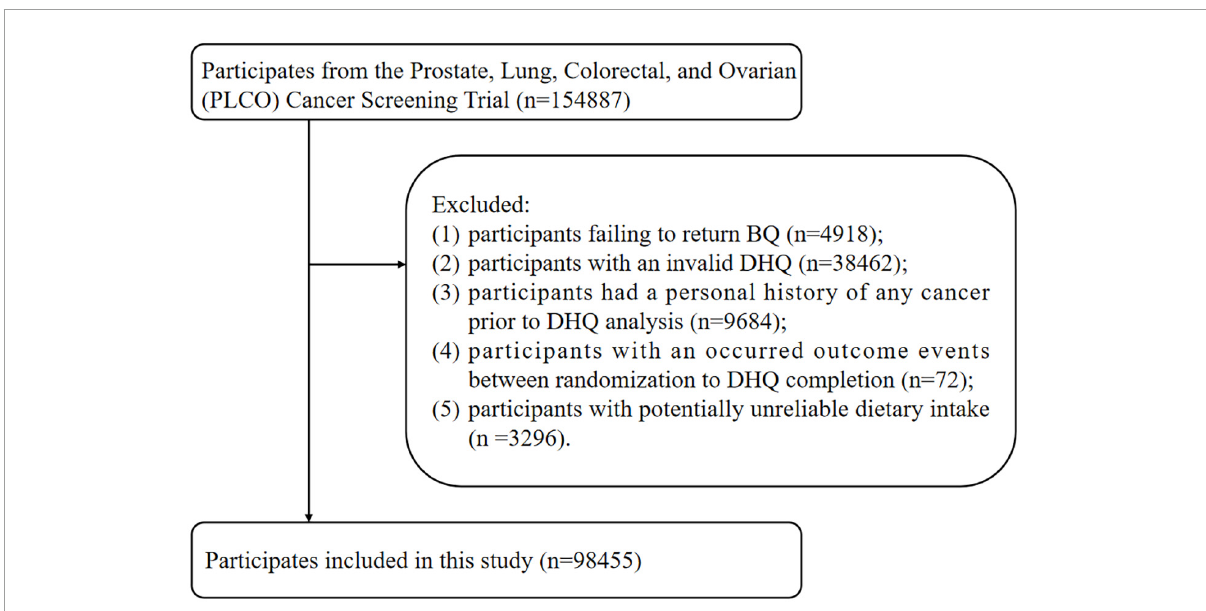
FIGURE1 The study flow chart of identifying eligible participants. PLCO, Prostate, Lung, Colorectal, and Ovarian; BQ, baseline questionnaire; DHQ, diet history